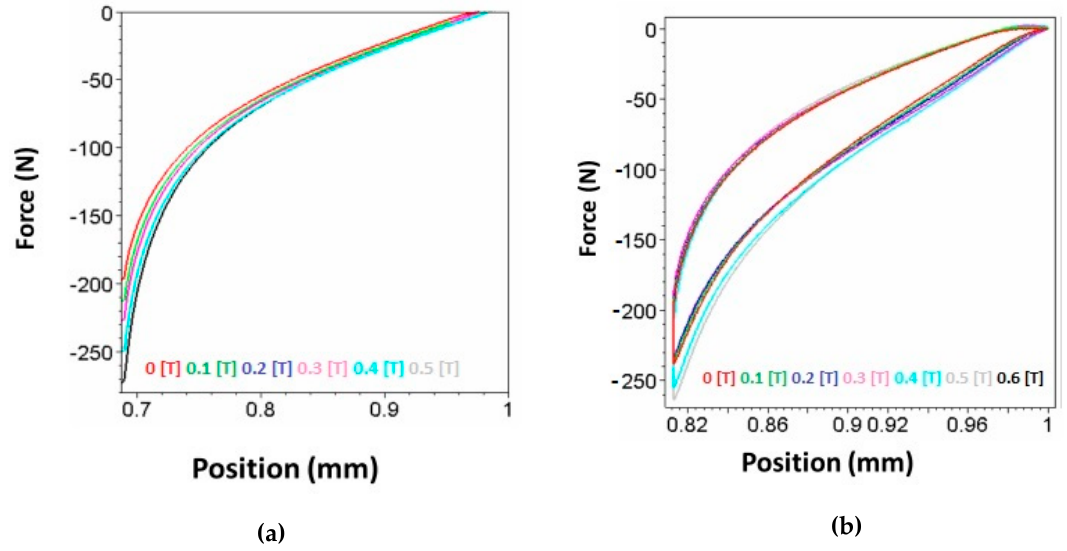
Figure 15. Force versus position for the MRE sample under static with single valve and deformation mode under various magnetic flux intensity (T). ( a ) Force versus displacement for compression; ( b ) relaxation stage at various magnetic intensity. Reprinted from [20], © 2016 with permission from Elsevier.